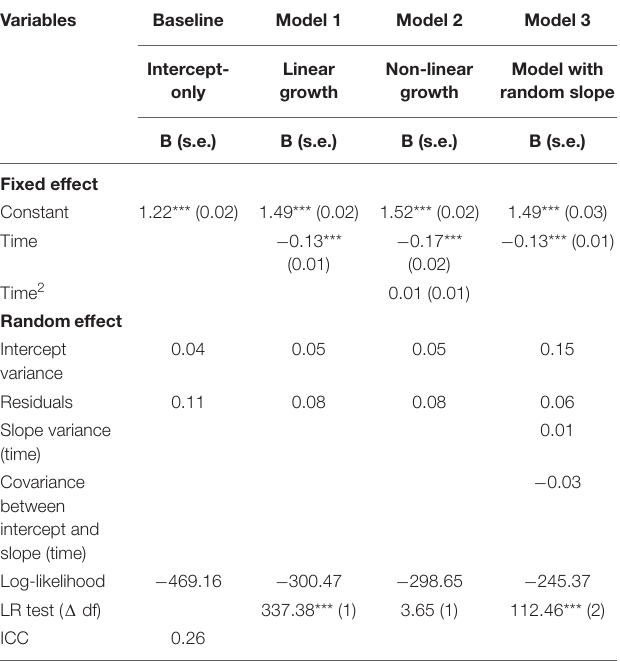
TABLE 6 | Cohort 1: results of ME growth models for changes in ANS RT (in sec.) from grade 1 to grade 5.